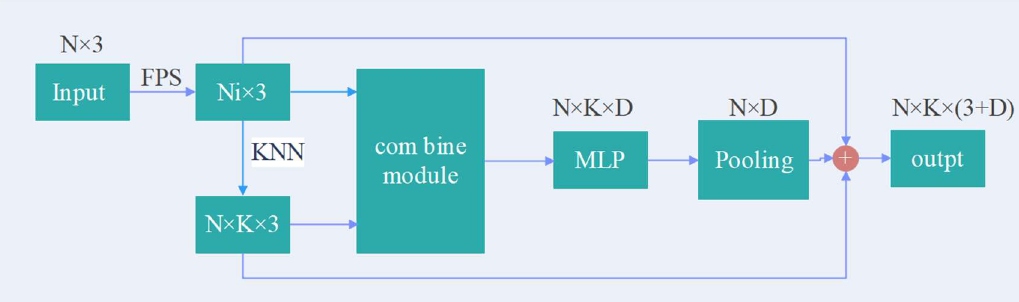
8 of 20 Figure 3. Overall structure of network. 3.3.1. SC Feature Learning Module In Figure 3, N is the number of central sampling points, D is the feature dimension of each point, and D = 3 represents the input three-dimensional point cloud data. The input point cloud with dimension N × D is used for center–neighborhood and neighborhood– neighborhood feature learning by the SC module, as shown in Figure 4. In the SC module, the input point cloud is first sampled by FPS to obtain the target center point N i × 3, then the KNN neighborhood point sampling N i × K × 3 is performed on the center point, and then the two pieces of point cloud data are input into the combine module for center point and neighboring point sampling. Domain point relationship learning and feature extrac- tion are performed to obtain the feature information with dimensions N × K × D ; then, the data are put through the MLP and maximum pooling layers to obtain the feature infor- mation of dimension N × D . Finally, the point cloud is sampled by FPS and by KNN, and the feature information of neighborhood relationship N × K × (3 + D ) dimension features is obtained by splicing with the max pooling feature information. As shown in Figure 3, the input data pass through the first set of SC modules to output feature information with N /4 × 64 dimensions; after passing through the second, third, and fourth sets of SC mod-